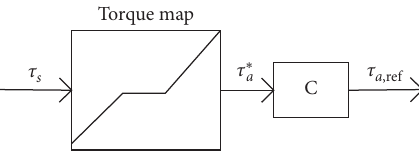
Figure 3: Controller structure of the EPS.